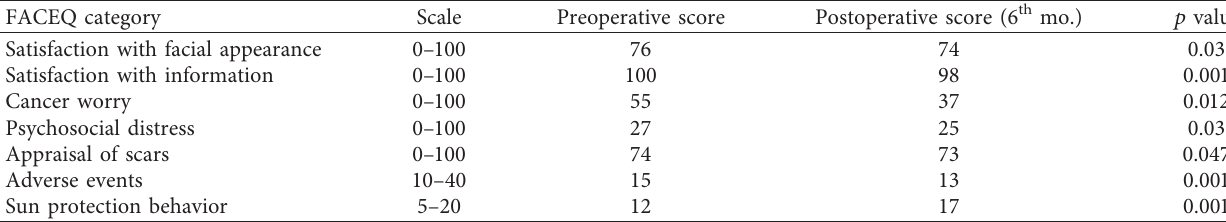
Table 3: Mean FaceQ skin cancer module